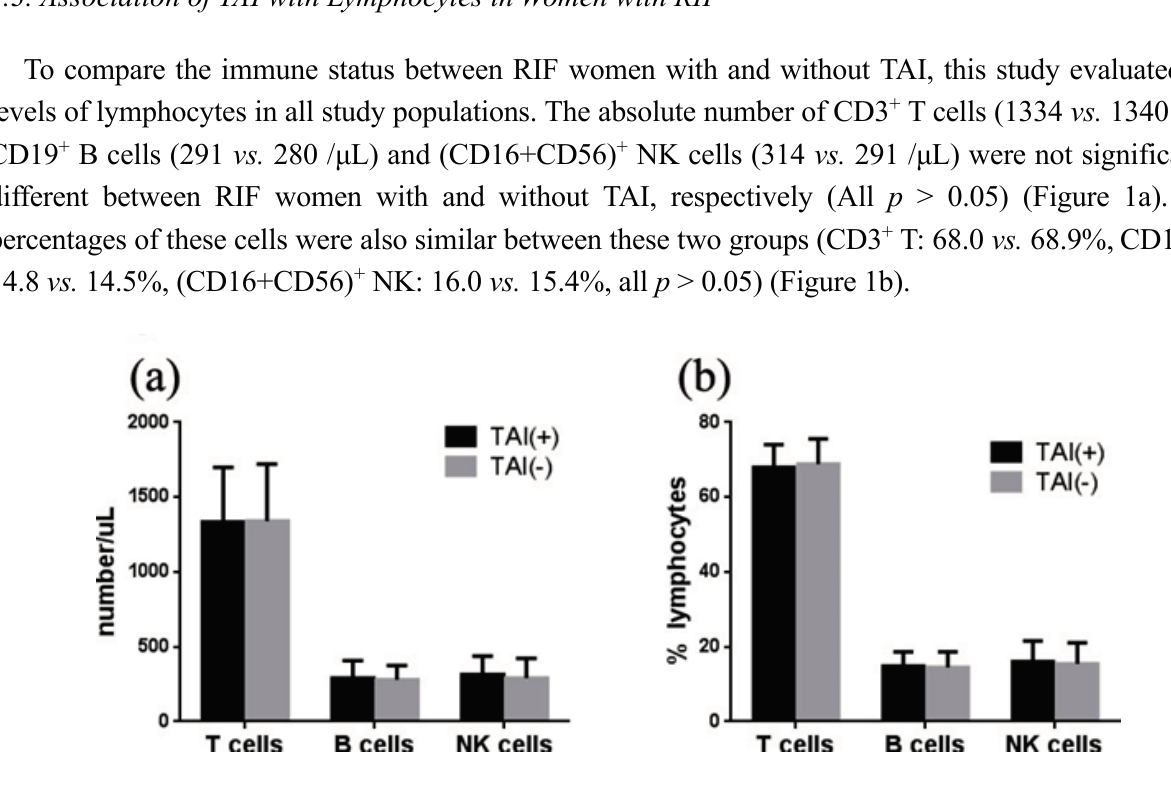
Figure 1. Association of TAI with lymphocytes in women with RIF. ( a ) The absolute number of T, B, and NK cells was not significantly different between RIF women with and without TAI. ( b ) The percentage of T, B, and NK cells was similar between RIF women with and without